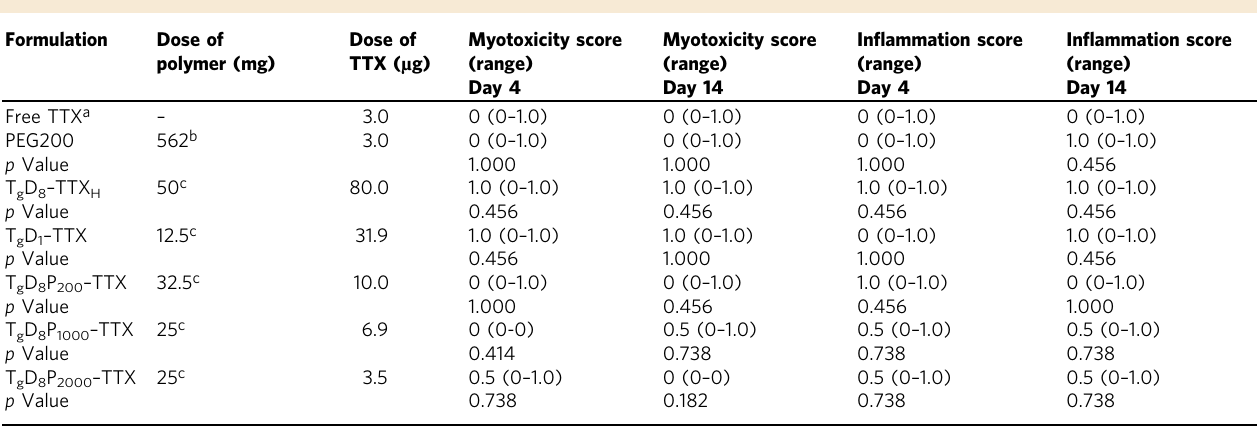
Data are medians with interquartile ranges. P values are for the comparison of the tissue reaction of test compounds to that of free TTX. n = 3 per experimental group. In fl ammation scores range: 0 – 4; myotoxicity scores range: 0 – 6 a 3 µ g of free TTX in 0.5mL of PBS b 3 µ g of free TTX in 0.5mL of PEG200 c TD – TTX and TDP – TTX conjugates were formulated in 0.5mL of